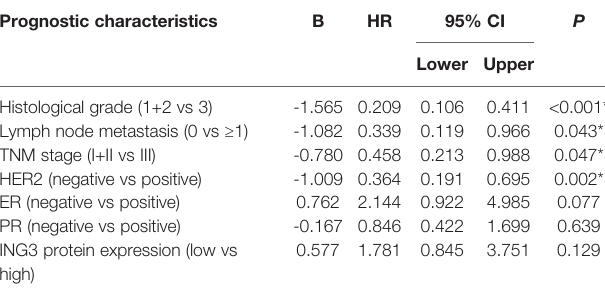
TABLE 3 | Multivariate Cox regression analysis of prognostic variables including classical prognostic factors and nuclear ING3 for 5-year OS in 211 cases of breast cancer